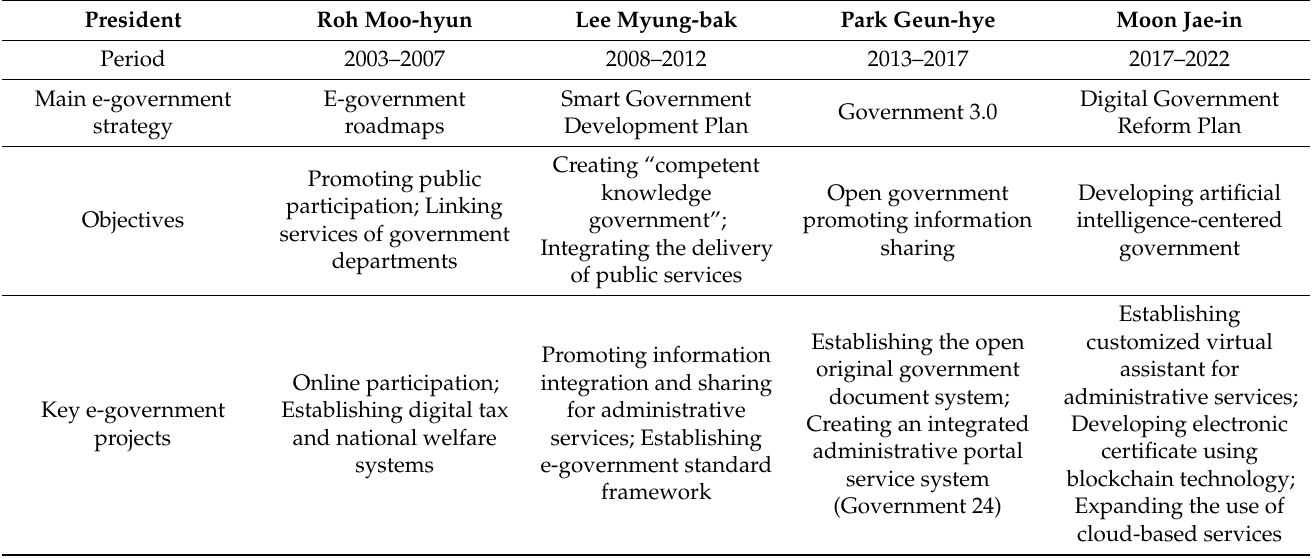
Table 3. E-government Policy During the Mature Phase of E-government Development in South